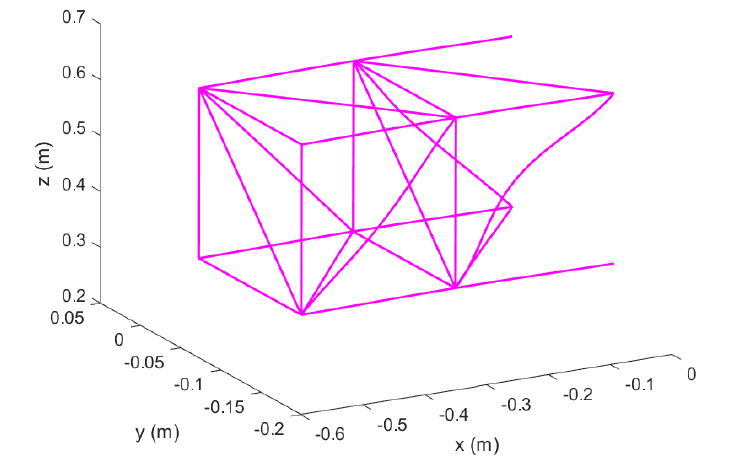
Figure 14. Mode 4 of Euler–Bernoulli Beams in Topology 1 with no hinged ends; original